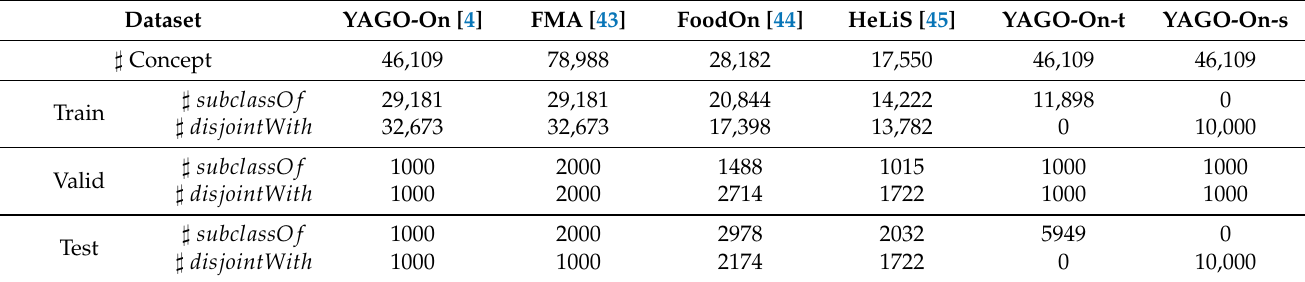
Table 1. The statistics of generated datasets for